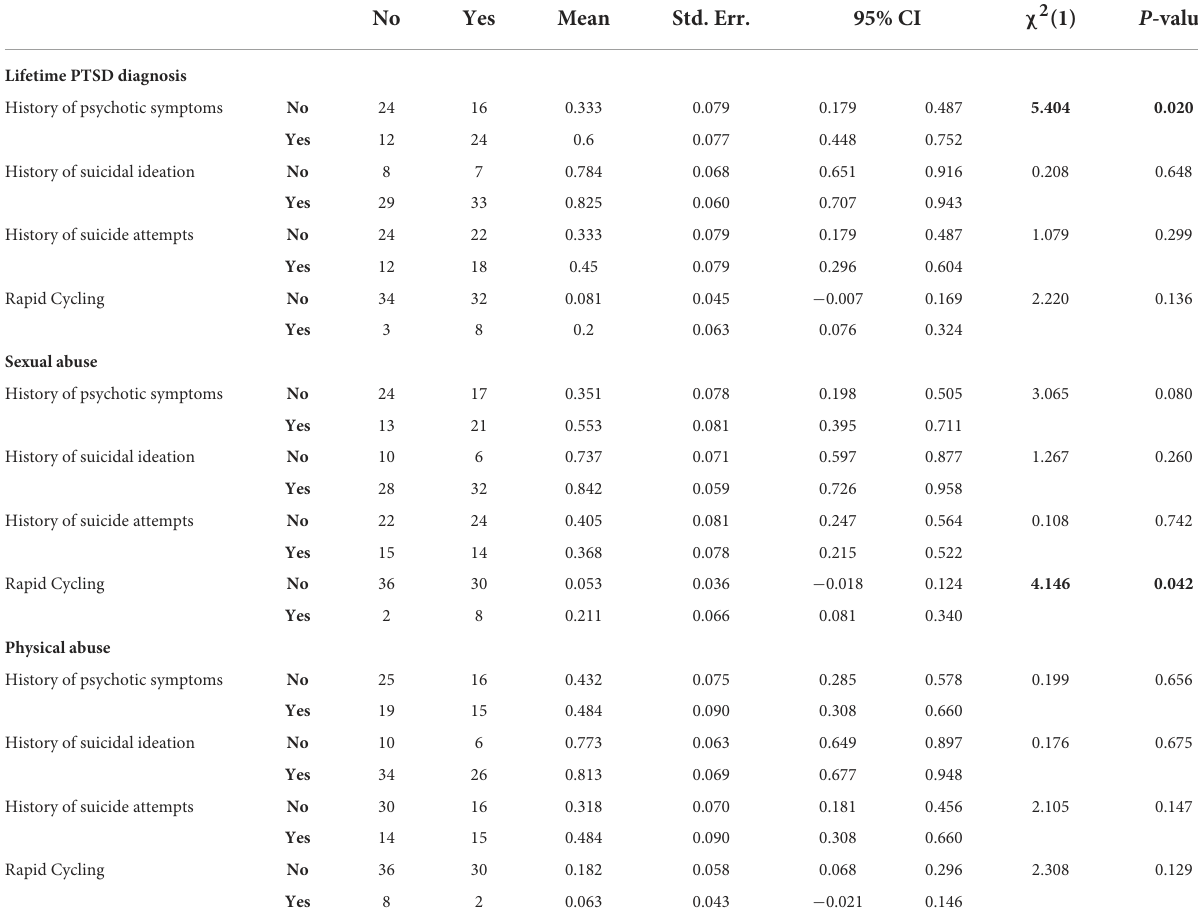
TABLE 3 The impact of a lifetime PTSD diagnosis, sexual and physical abuse on categorical variables of disease course.